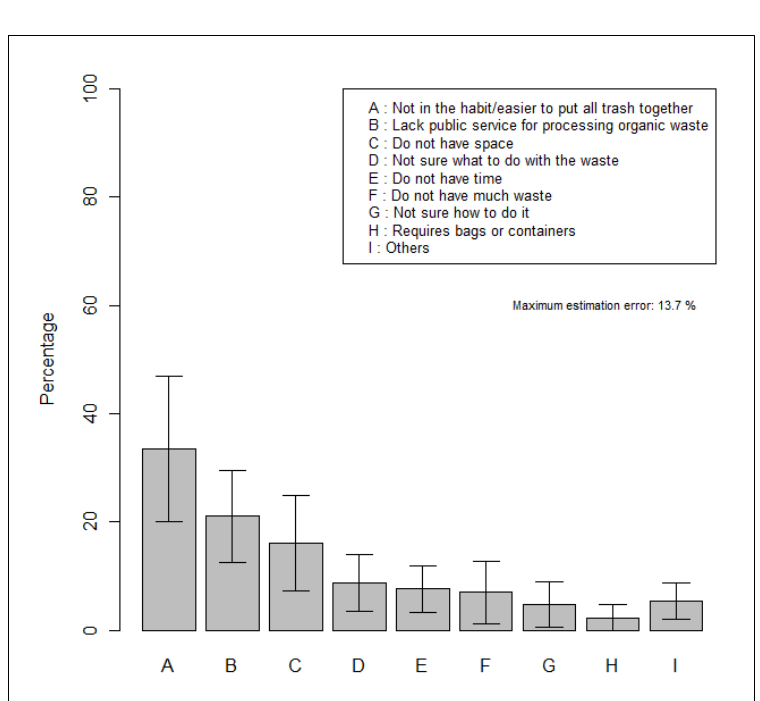
Figure 4. Reasons Why Respondents Willing To Separate Do Not Currently Do So (n=137)